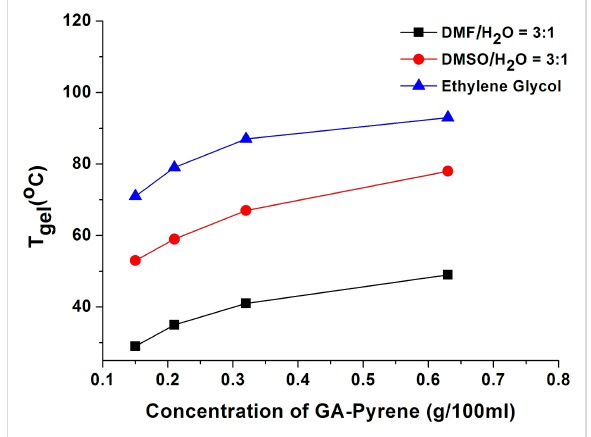
Figure 2: T gel of GA-pyrene ( 3 ) and TNF ( 4 , 1:1, molar ratio) with the increasing concentration in different solvents.